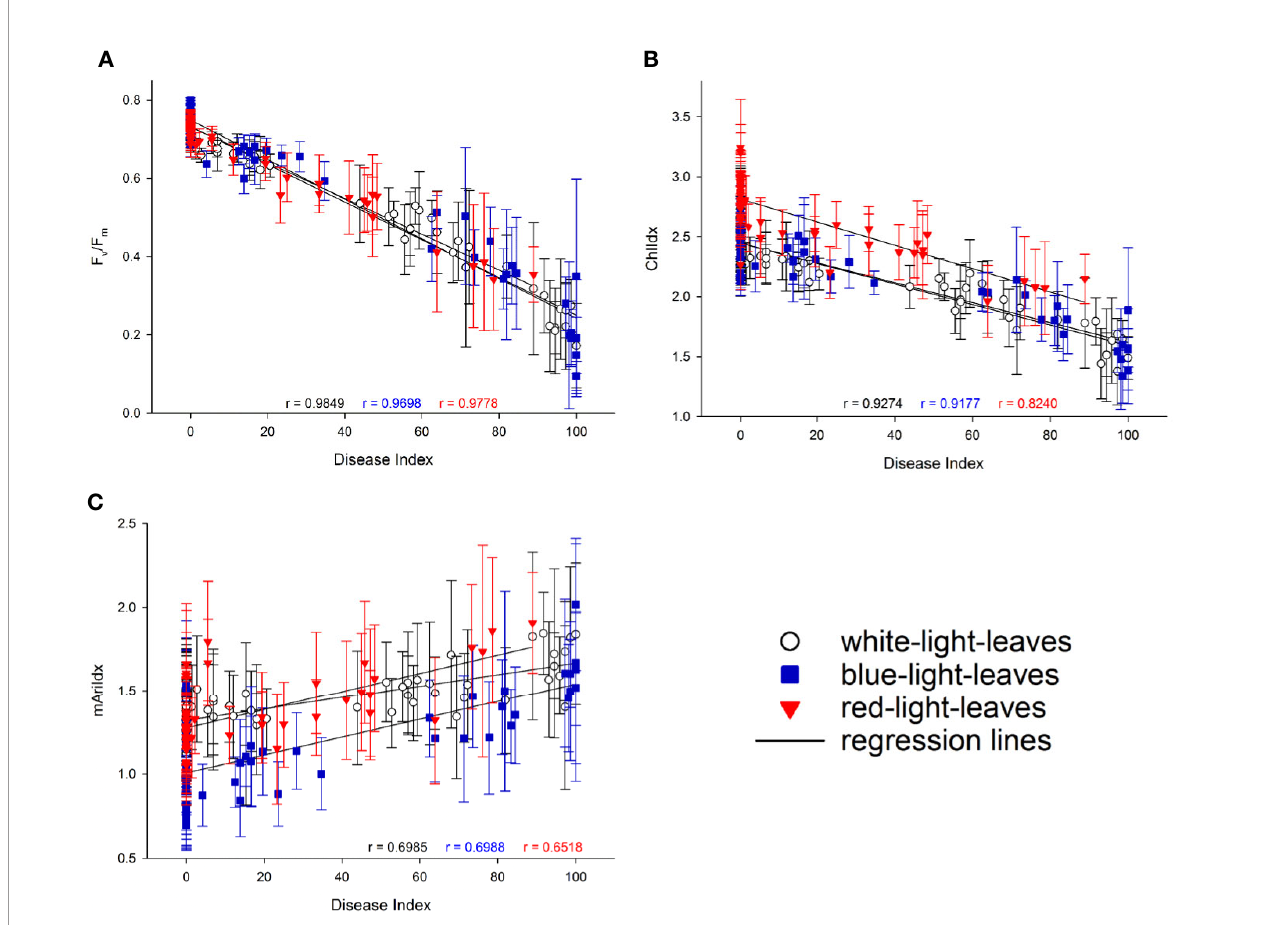
FIGURE 8 | Correlations between disease index and F v /F m (A) , ChlIdx (B) , and mAriIdx (C) on strawberry leaves from white (in white), blue (in blue), and red (in red) LED lights. Values are presented as means with standard deviation shown by vertical bar. The Pearson correlation r is shown in colors to indicate the corresponding light